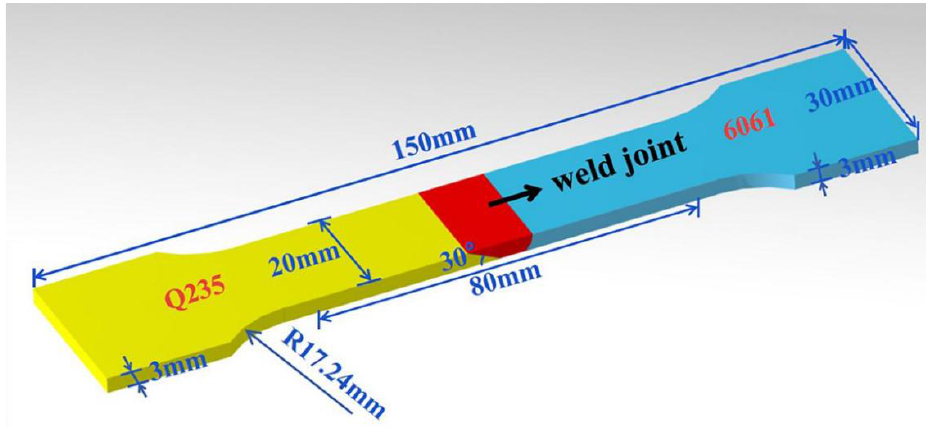
Figure 2. Tension coupon.